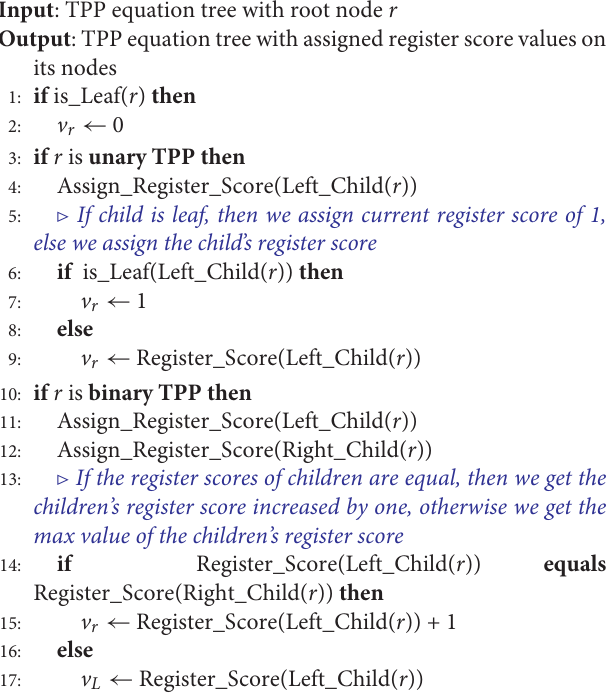
Algorithm 3 | Assign_Register_Score( r ).